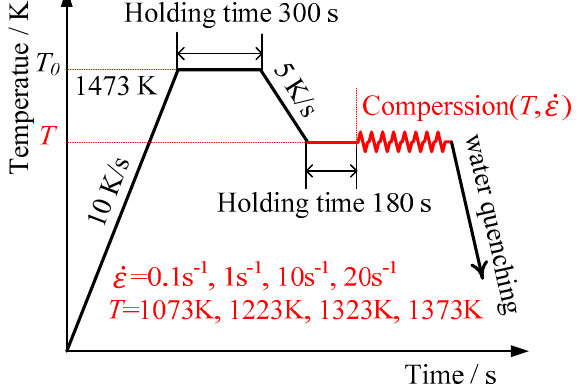
Figure 2. Thermal simulation process curve.